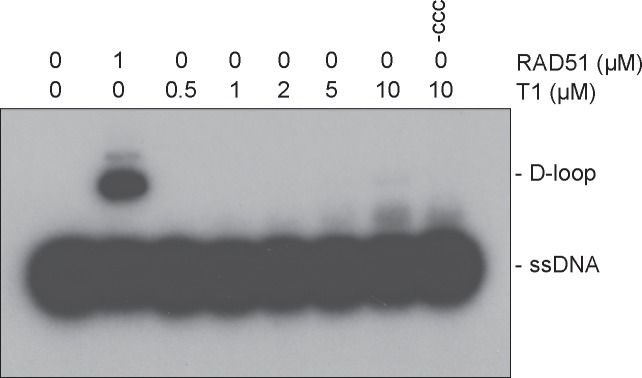
PALB2 N-DBD cannot form D-loops with supercoiled dsDNA plasmid.Products of the D-loop reaction mediated by PALB2 N-DBD fragment with 100-mer single strand DNA oligonucleotide (JYM1413, 1 µM) and supercoiled dsDNA plasmid pPB4.3 (300 µM) for 5 min separated by gel electrophoresis. RAD51 (1 µM) was used as a positive control (line 2). ‘ccc’ line is a control without plasmid. T1 fragment did not stimulate RAD51 D-loop formation activity in this assay as well (not shown).